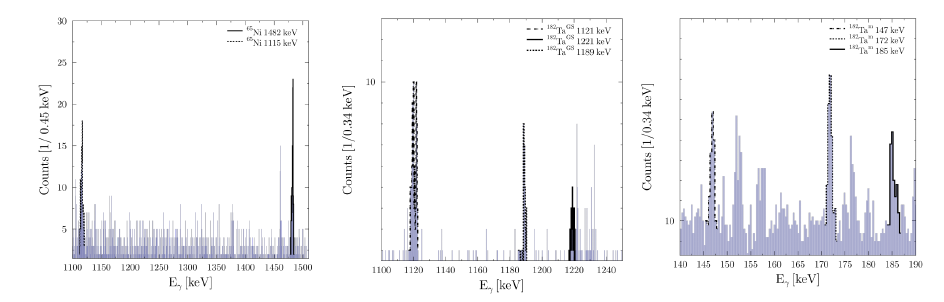
Figure 3. Measurements using γ -spectroscopy for the reactions for low s-process temper- atures at k B T = 6keV for the reactions Left: 64 Ni(n, γ ) 65 Ni, Middle: 181 Ta(n, γ ) 182 Ta, and Right: 181 Ta(n, γ ) 182 Ta m .